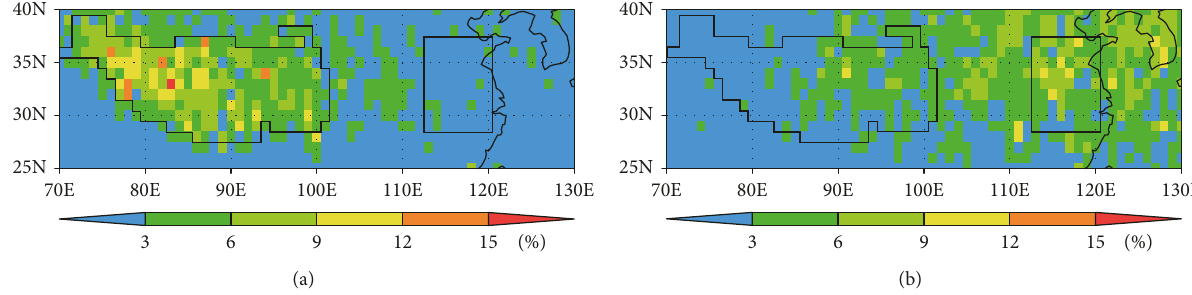
Figure 1: Occurrence averaged vertically for (a) range A and (b) range B both ranges A and B are defined as in Figure 3. The left closed region represents the TP, and the right closed region represents the